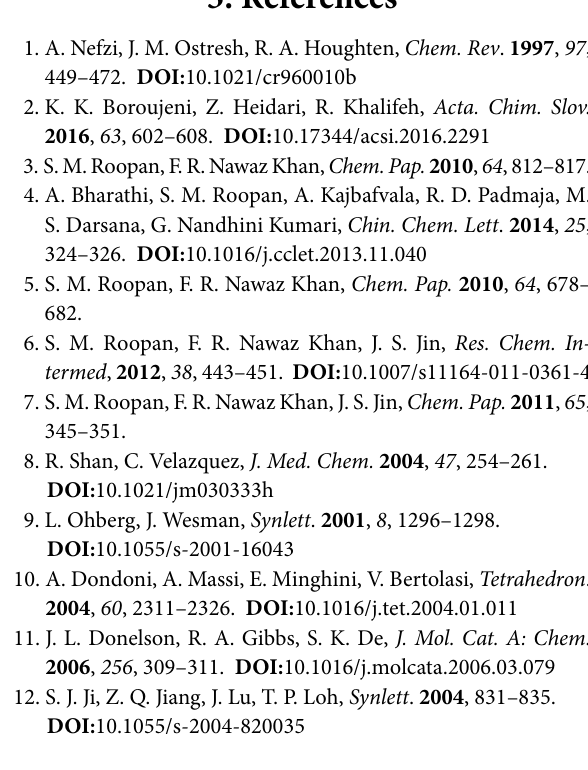
Table 3 . Reusability of the Fe Number of cycle Yield (%)